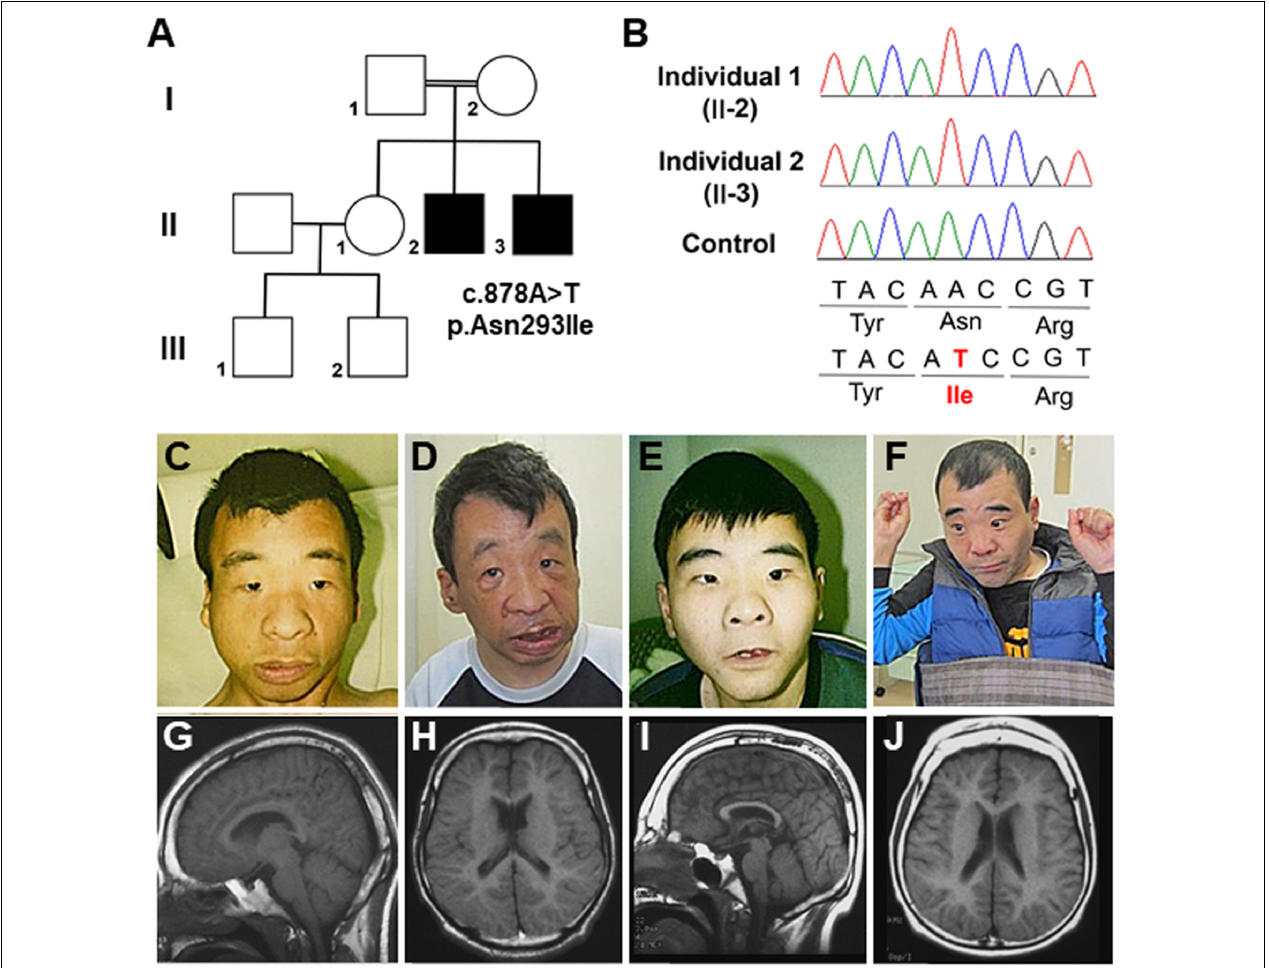
FIGURE 1 | (A) Familial pedigree of the affected male siblings. (B) Electropherograms of the OTUD5 variant (c.878A > T, p.Asn293Ile [NM_017602.4]) in the affected brothers and the control. (C,D) Photographs of the older brother (II-2) at 22 and 48 years of age. (E,F) Photographs of the younger brother (II-3) at 20 and 46 years of age. (G,H) Brain magnetic resonance images (MRI). Sagittal and coronal views of T1 susceptibility-weighted images of the older brother at 24 years of age are shown. A thin corpus callosum, a small frontal lobe, and volume loss of the subcortical white matter and cavity of the septum pellucidum can be seen. (I,J) Brain MRI. Sagittal and coronal views of T1 susceptibility-weighted (SW) images of the younger brother at 22 years of age are shown. A thin corpus callosum, frontal lobe hypoplasia, volume loss of the subcortical white matter, colpocephaly, and hypoplasia of the cerebellar hemispheres can be